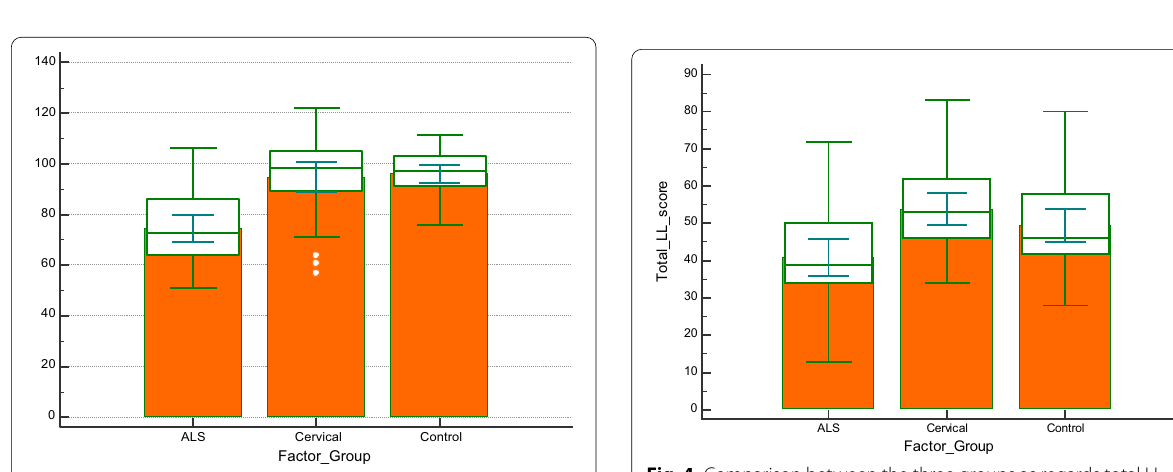
Fig. 3 Comparison between the three groups as regards total UL Fig. 4 Comparison between the three groups as regards total